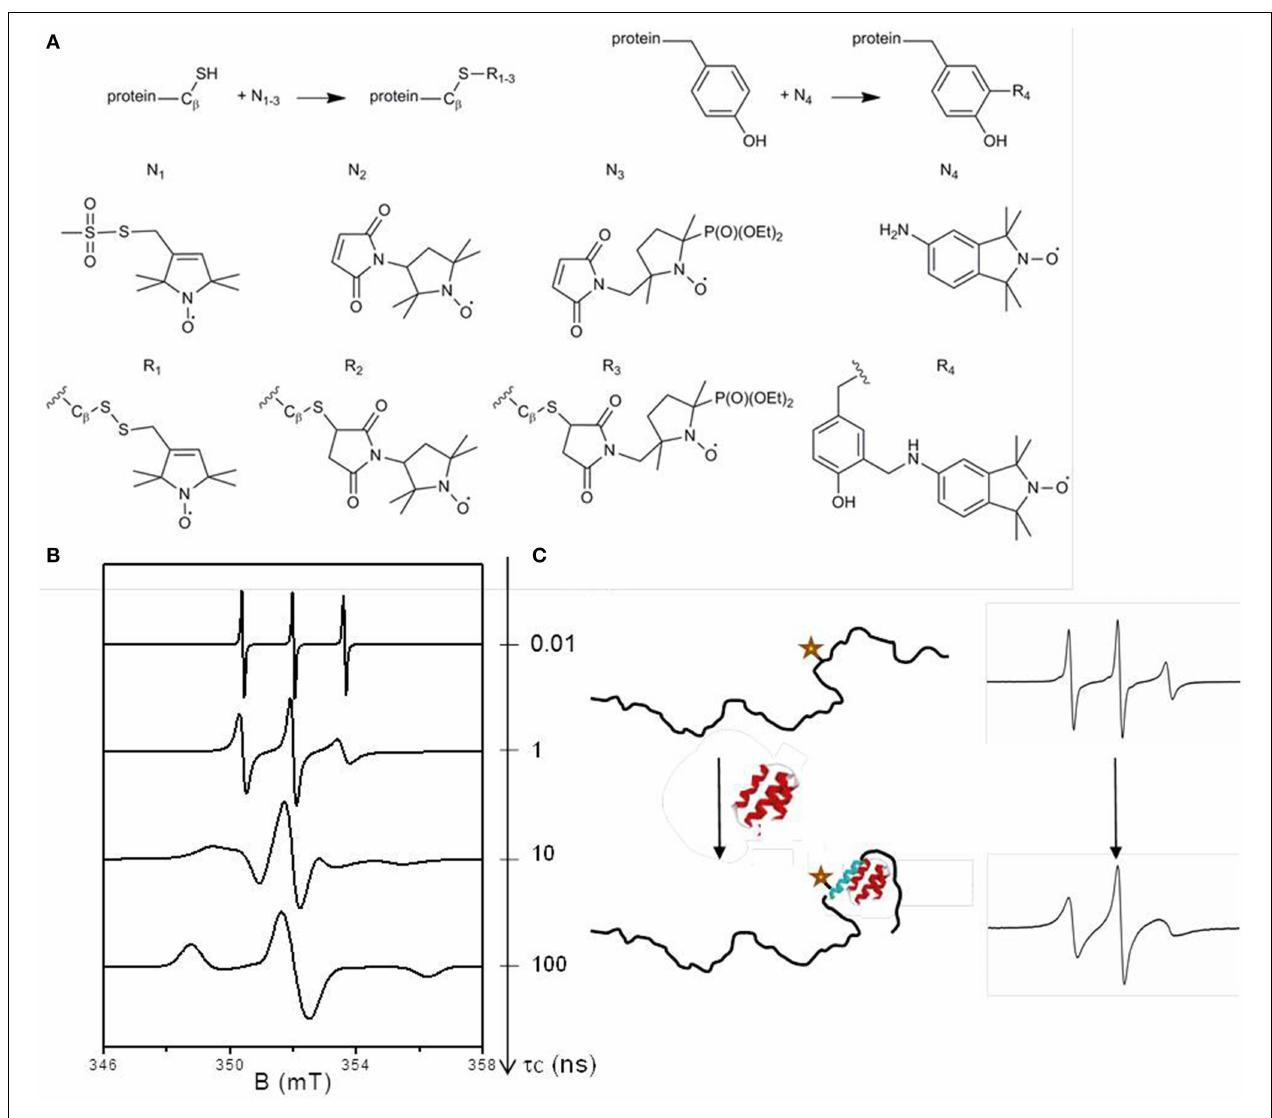
the mobility of the spin label described by its rotational correlation time τ c . The spectra were simulated using the EasySpin software (Stoll and Schweiger, 2006) for different values of τ c : 0.01, 1, 10, and 100 ns. (C) Illustration of an EPR spectral shape broadening in the case of a disorder-to-order transition due to an induced folding mechanism. The star represents the spin